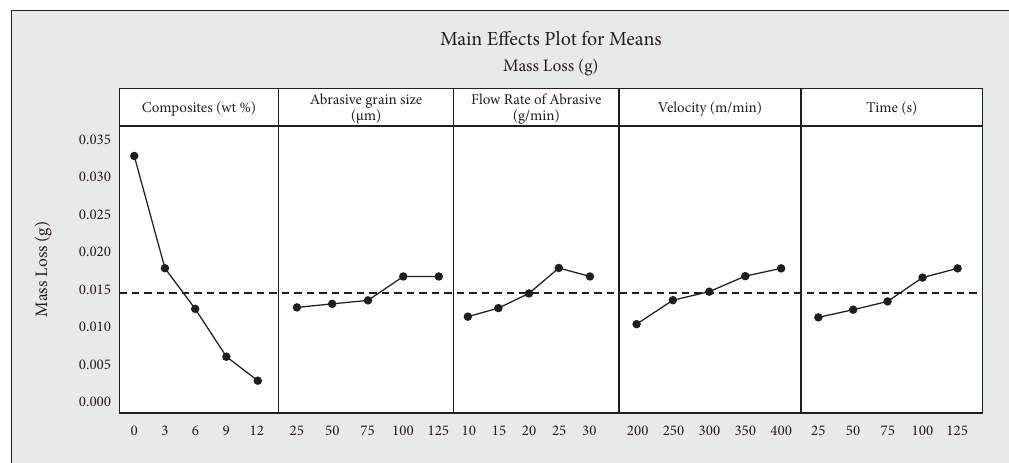
Figure 3: Main efect plots for means.